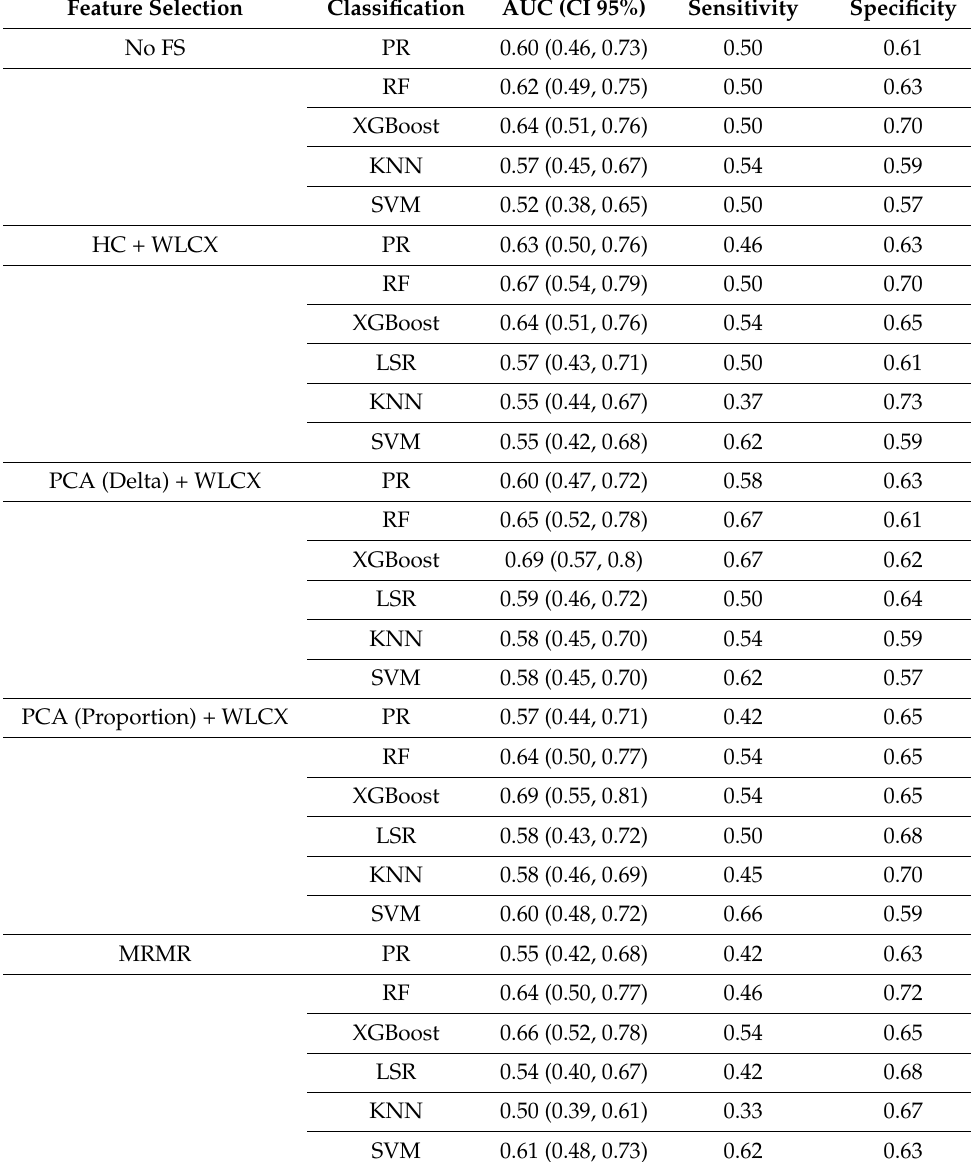
Table 4. Discriminative performance of combinations of feature selection and classification methods applied to real